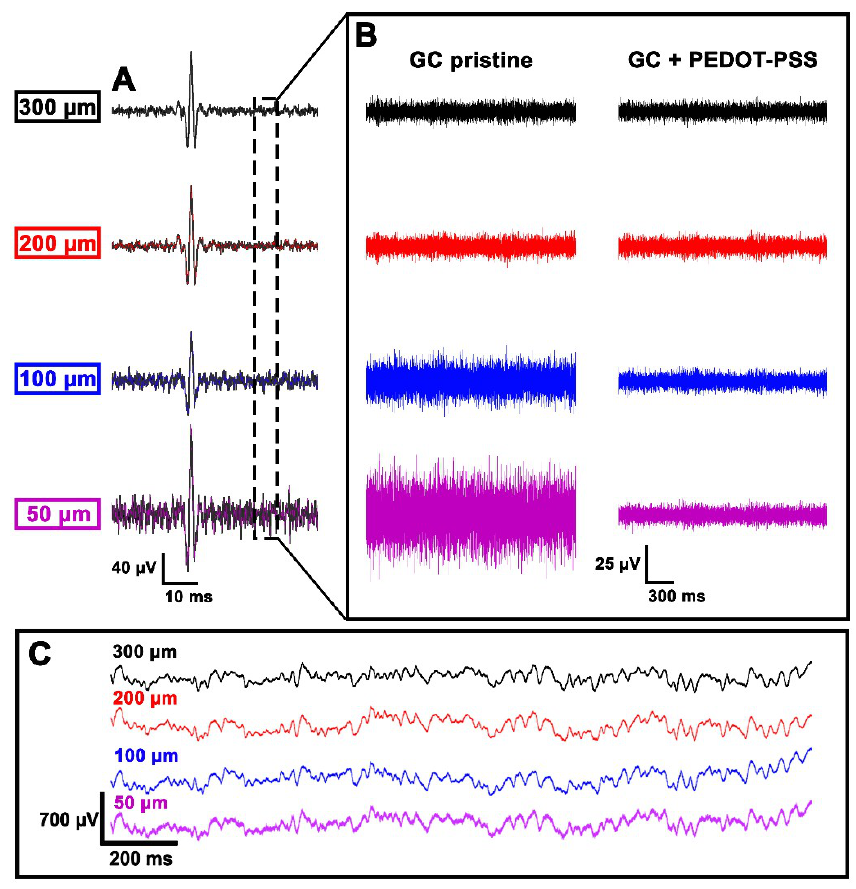
Figure 11. Representative continuous traces of one trial ( A ) recorded by all the electrode diameters after high-pass filtering the data above 200 Hz. The grey box ( B ) represents the magnification of a small time window of spontaneous activity in order to highlight the background noise for every electrode diameter before and after PEDOT:PSS deposition. Box ( C ) shows ECoG raw data recorded from pristine GC electrodes of various diameter.